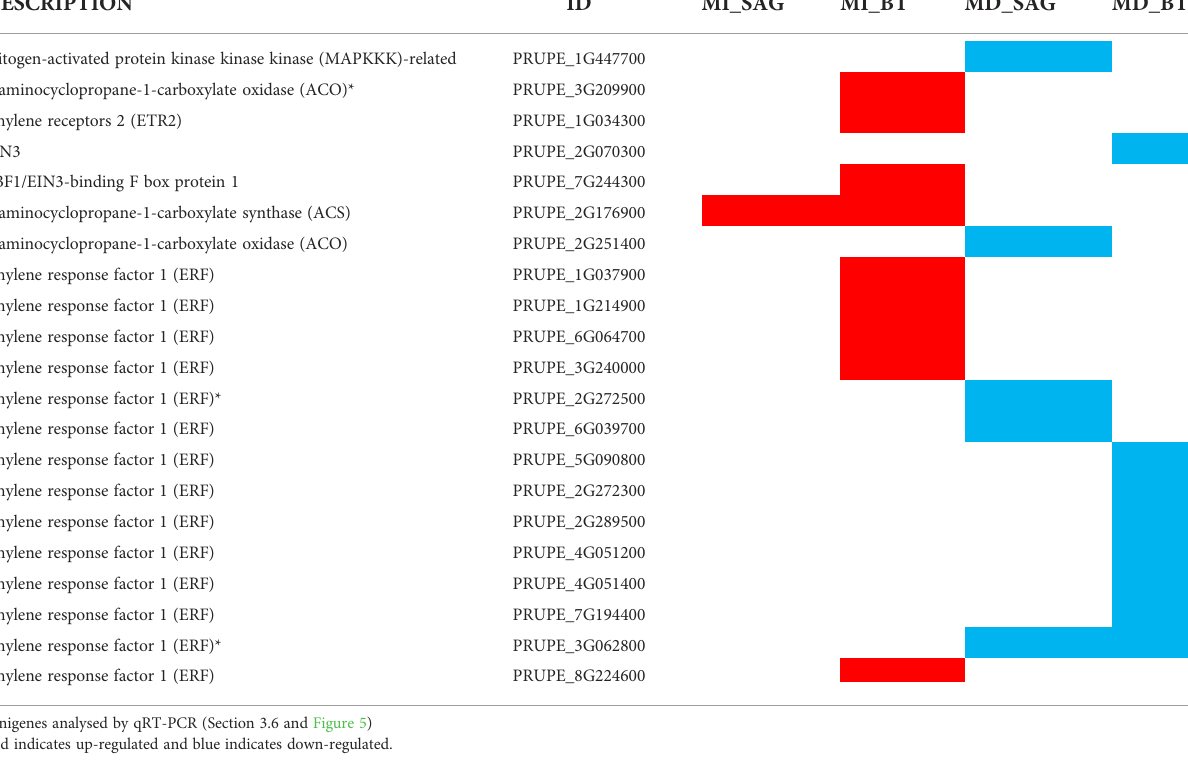
TABLE 1 Expression in transcriptome of monotone genes related to ethylene biosynthesis and signaling. DESCRIPTION